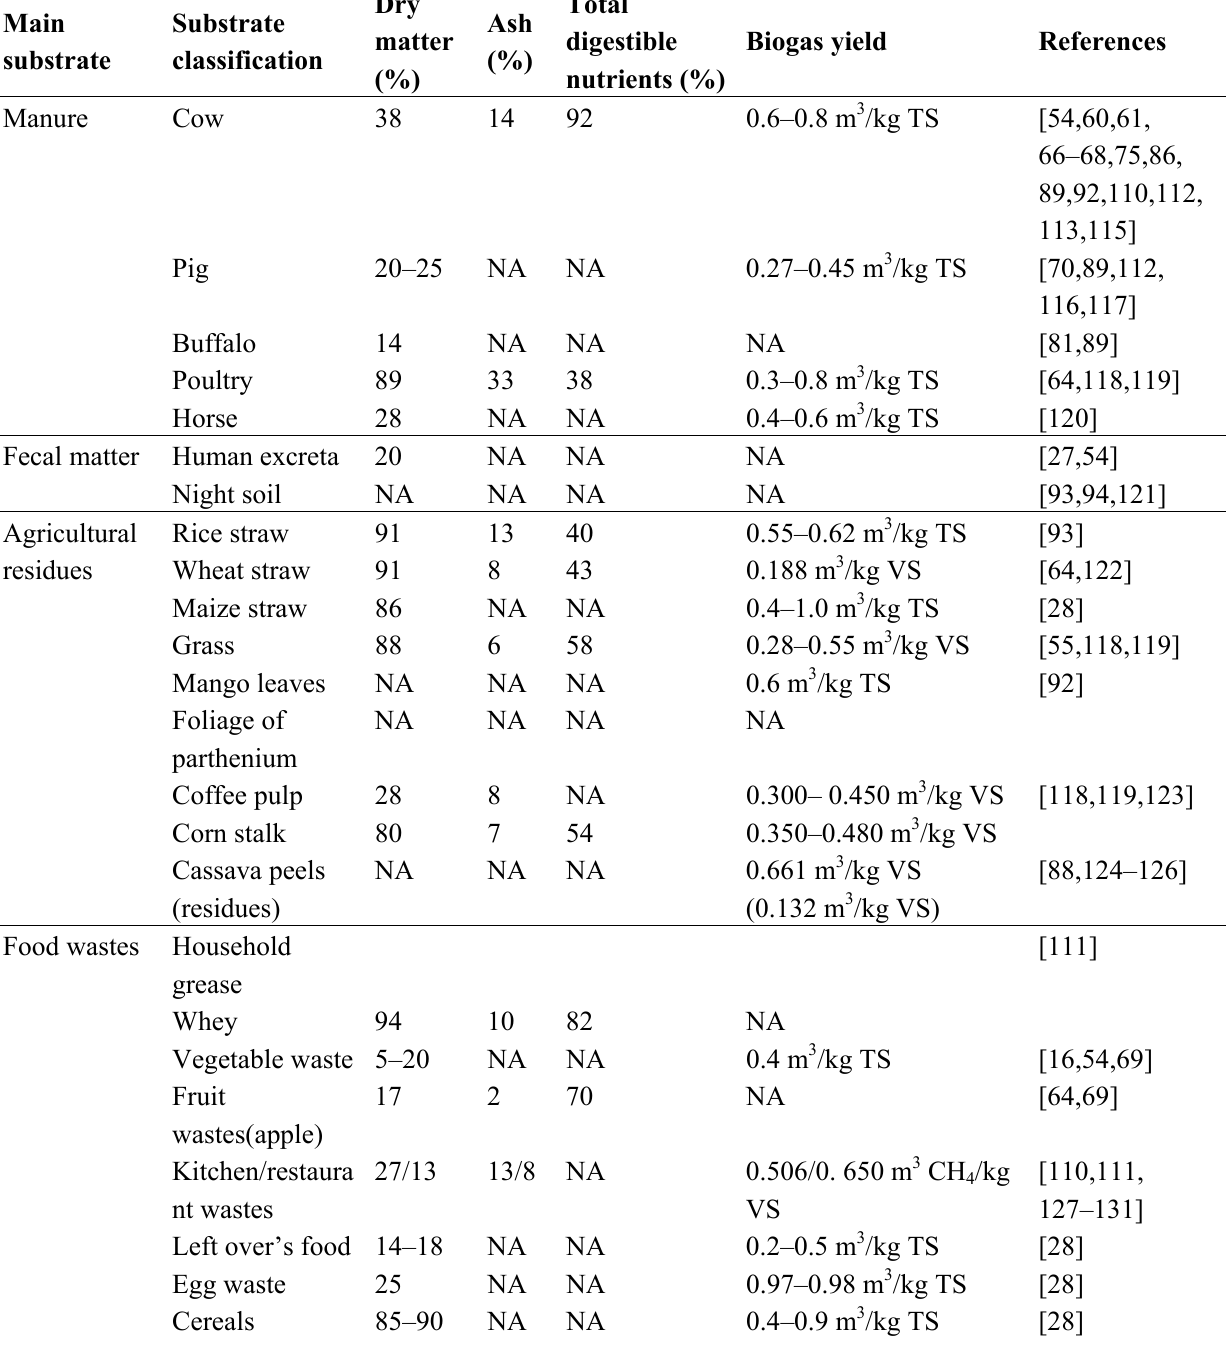
Table 2. Different substrates with corresponding dry matter, ash content, total digestible nutrients and biogas yield used in the household biogas digesters